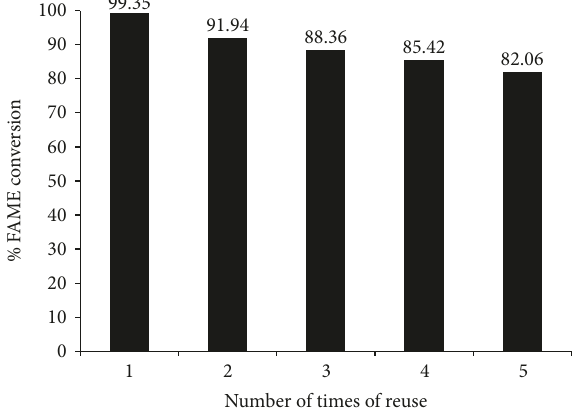
Figure 6: Ca(OCH 3 ) 2 catalyst reusability